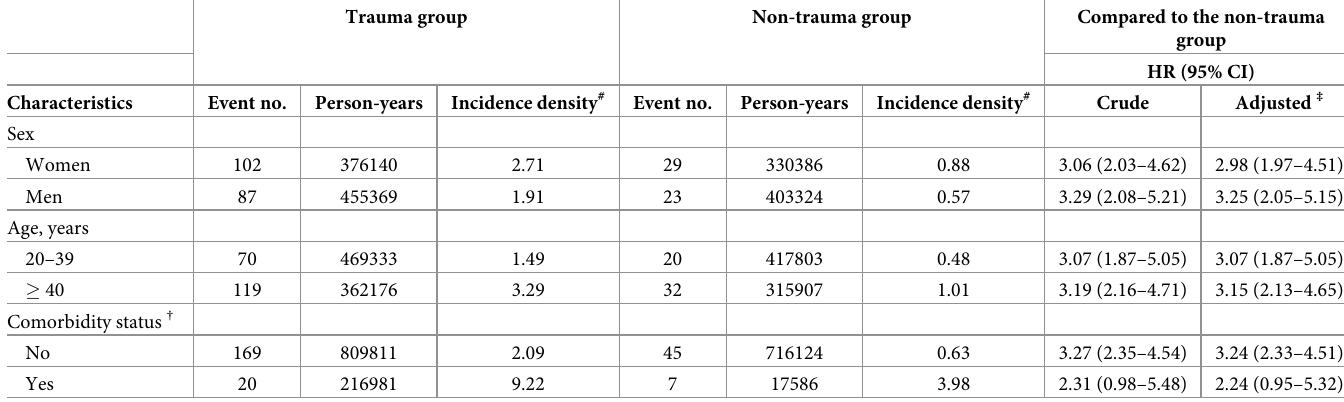
Table 3. Incidence density and hazard ratios of dystonia according to trauma status stratified by sex, age, and comorbidity.